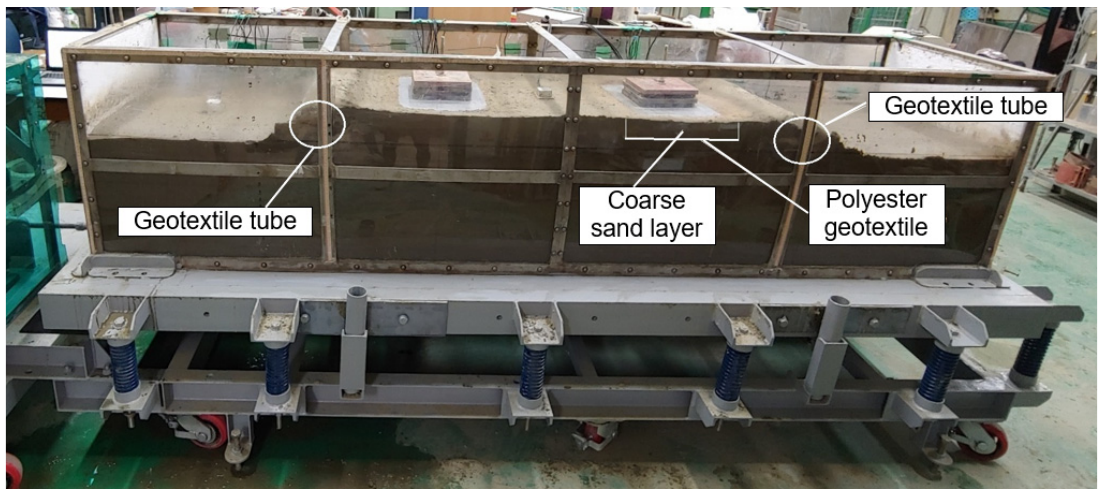
Figure 10. Actual photo of shaking table test.